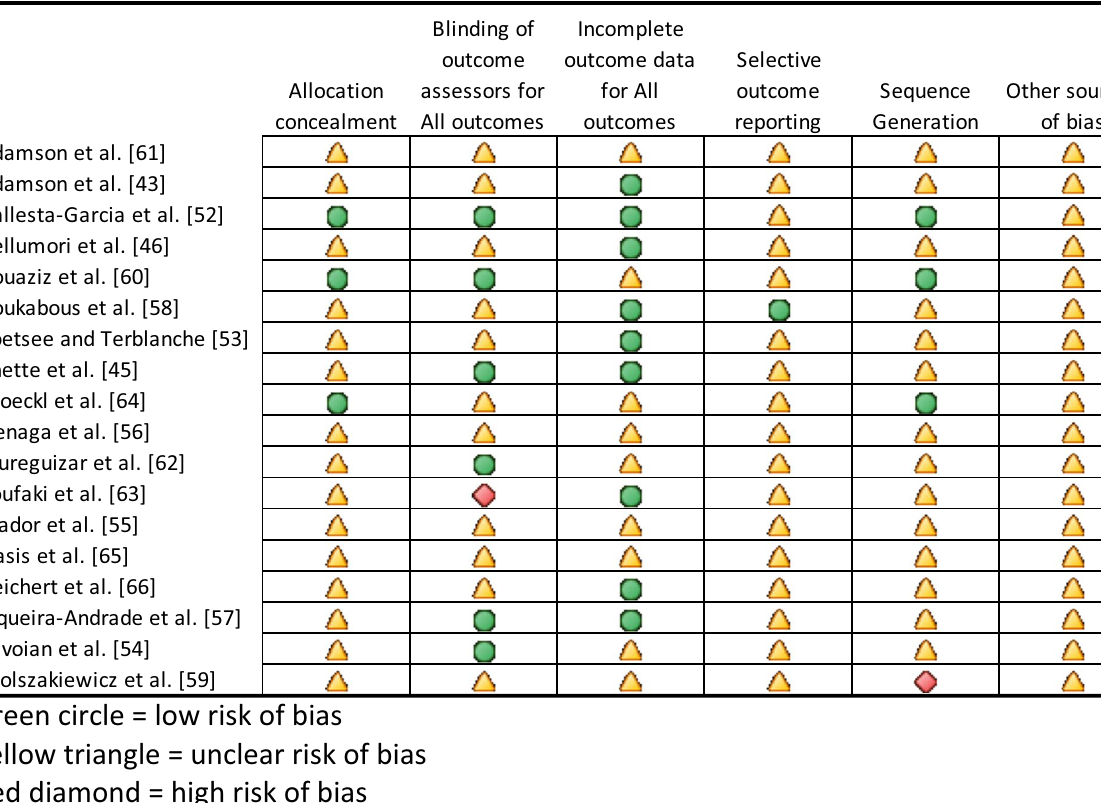
Fig. 8 Risk-of-bias summary. Green circle